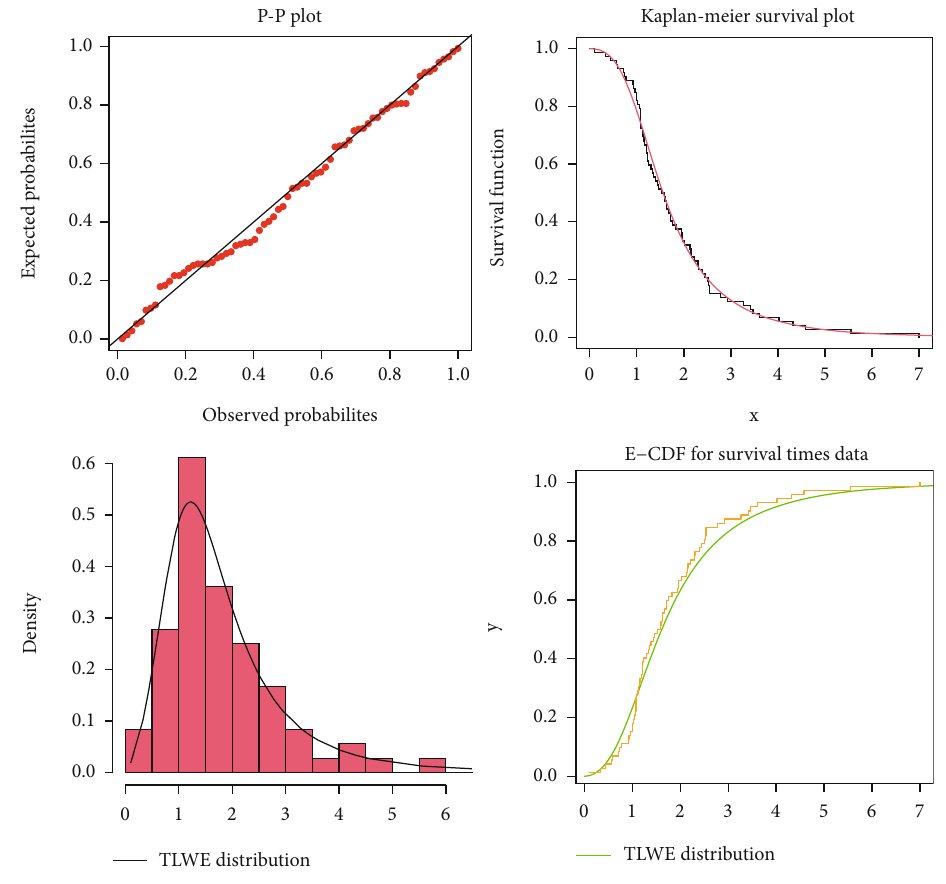
Figure 8: P-P, KMS plot, FPDF, and FCDF for the 2 nd